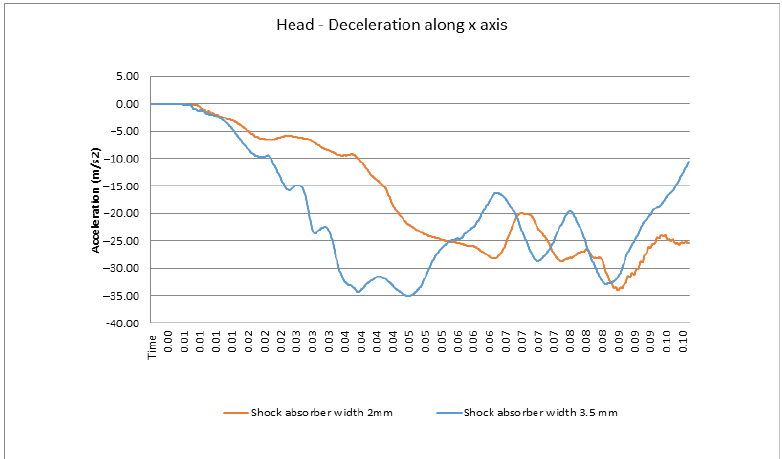
Figure 18. Acceleration registered by a virtual accelerometer in the thorax, v = 13 m/s.